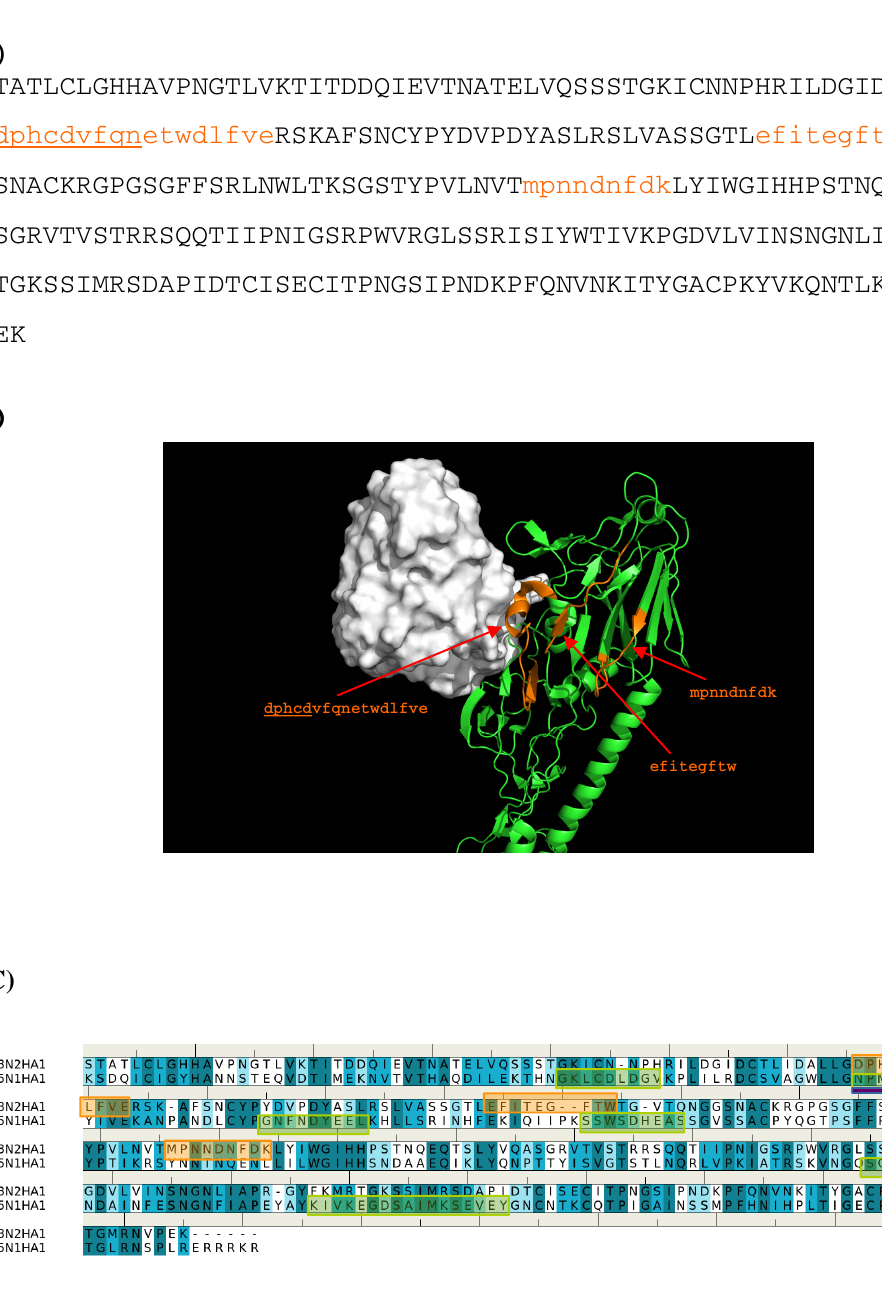
Figure 9. ( A ) the predicted epitopes of H3N2 HA1 ( A ) binding to antibody BH151. The epitopes are highlighted in lower case and colored orange in the protein sequence. ( B ) Backbone representation of the antigen H3N2 HA1 showing the predicted epitopes in orange and the antibody in surface. ( C ) Sequence alignment of HA1 protein of influenza viruses H3N2 and H5N1. The boxes